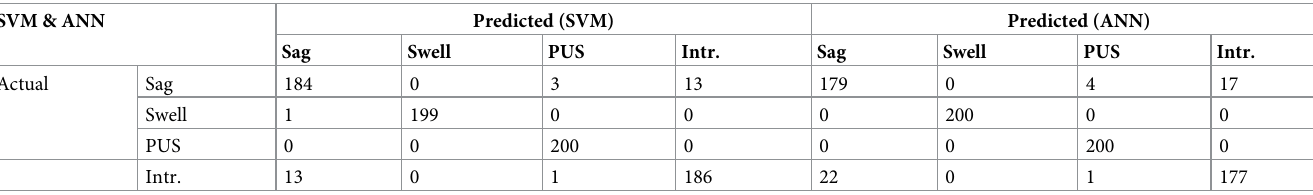
Table 5. Confusion matrices for the SVM and the ANN